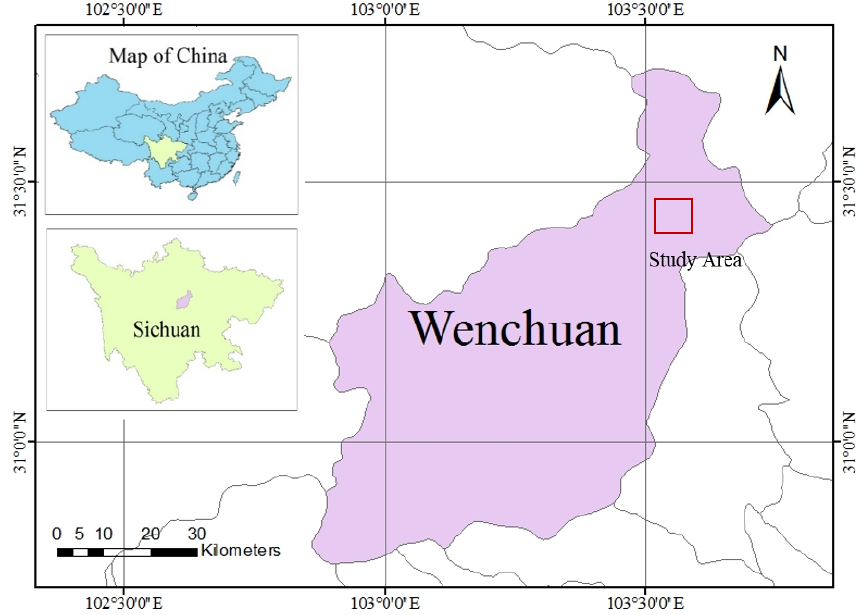
Figure 6. The spatial location of the study